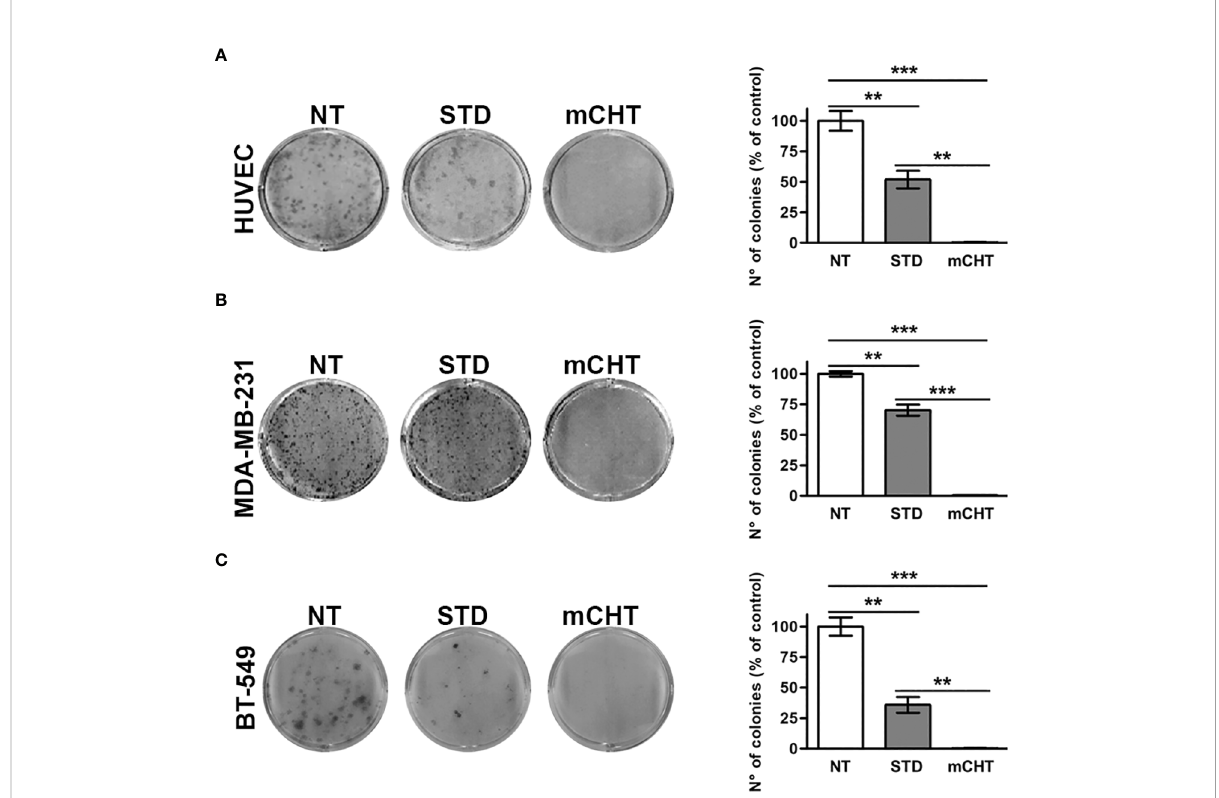
FIGURE 2 Metronomic administration of 5-FU+VNR is more effective than standard treatment in reducing HUVECs and TNBC cells colony formation. Representative images of colony formation assays stained 10 days after the end of STD or mCHT combination treatments of HUVECs (A) , MDA- MB-231 cells (B) and BT-549 (C) . Colonies were stained with crystal violet and counted. On the right of each panel number: number of colonies grown after treatments quanti fi ed as a percentage of untreated controls. Values represent the average ± SD of three independent experiments. **p < 0.01; ***p <